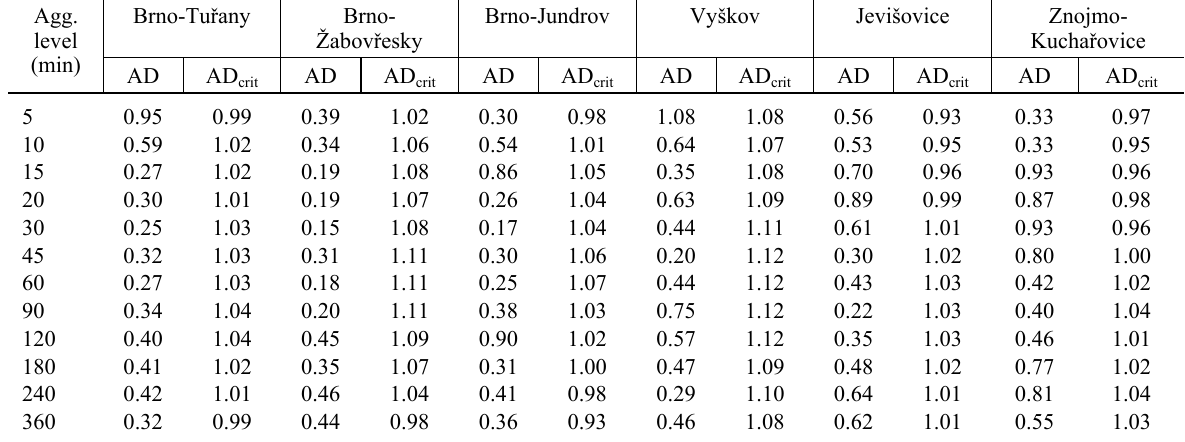
Table 3. Anderson–Darling statistics (AD) for given stations and aggregation levels with the corresponding critical values (AD crit ) Brno-Tu ř any Brno- Žabov ř